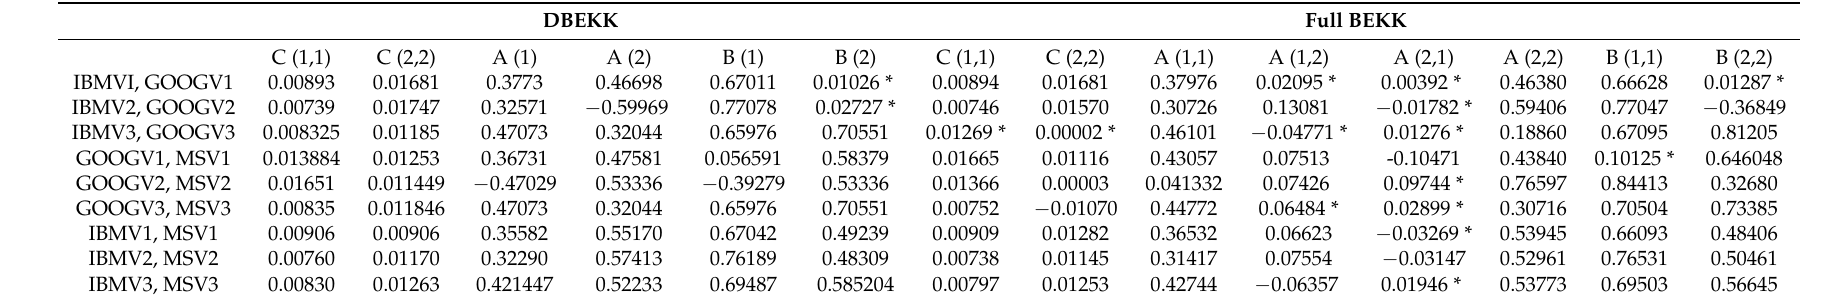
Table 4. Variable coefficient estimates for DBEKK and full BEKK.